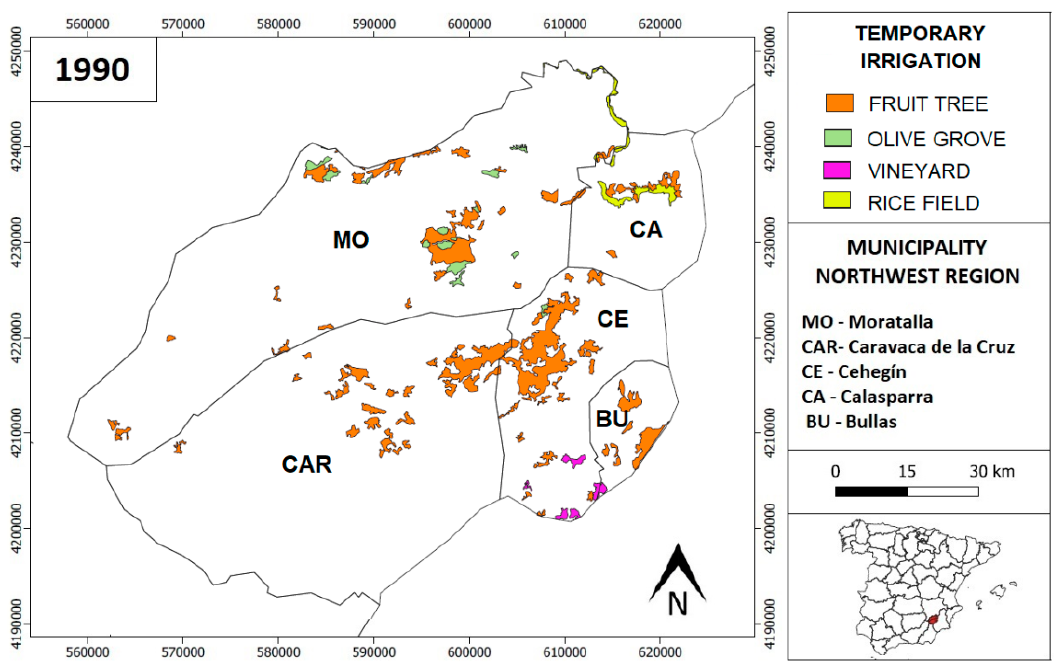
Figure 13. Spatial distribution of temporary irrigation crops (1990). Source: Authors.